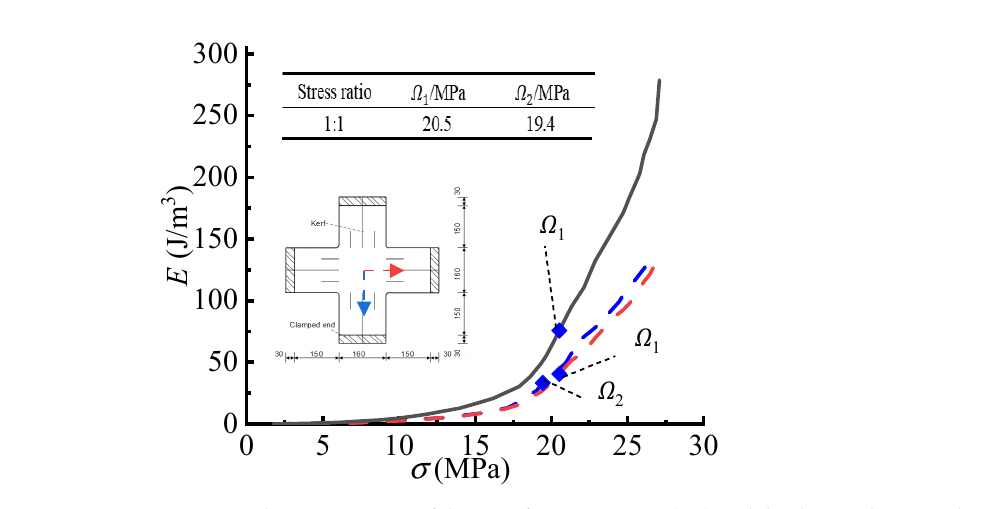
Figure 9. The σ − E curves of the cruciform specimens (1:2) and the detected essential principal stresses: ( a ) specimen 1, ( b ) specimen 2.